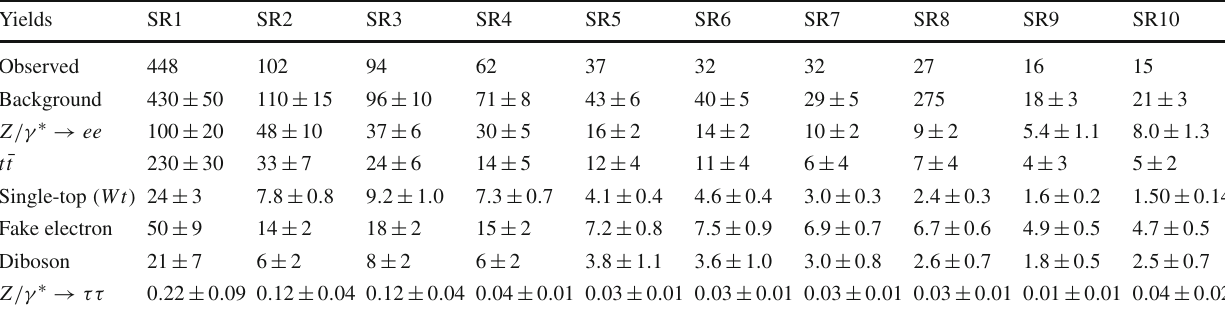
Table 9 Event yields in the signal regions of the eejj channel. Data are shown together with the background contributions after a combined background-only fit in the control and signal regions Yields SR1 SR2 SR3 Observed